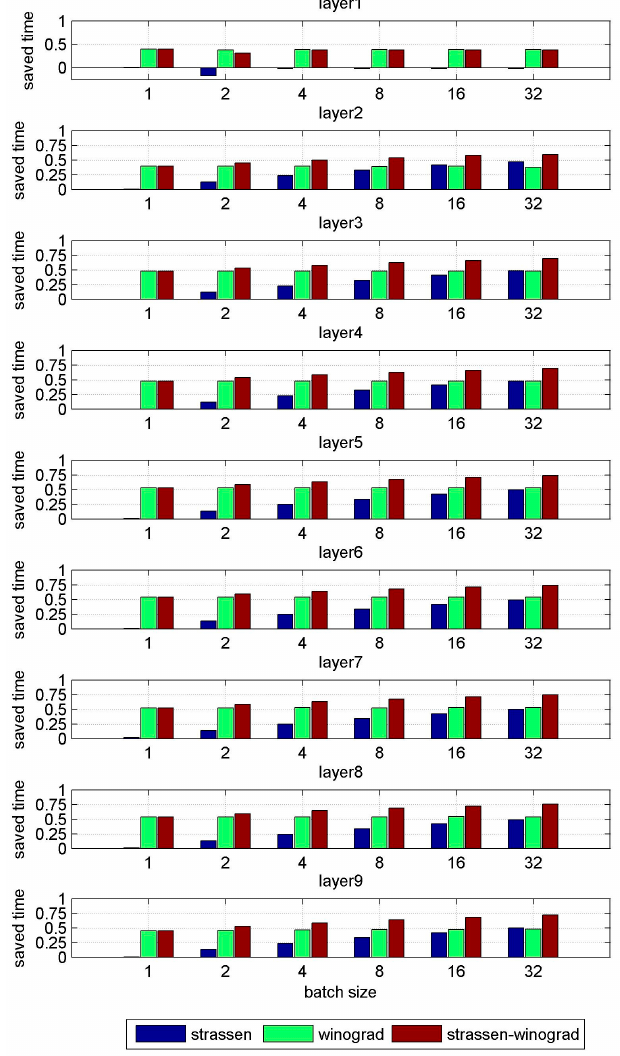
Figure 3. Comparisons with different batch sizes.